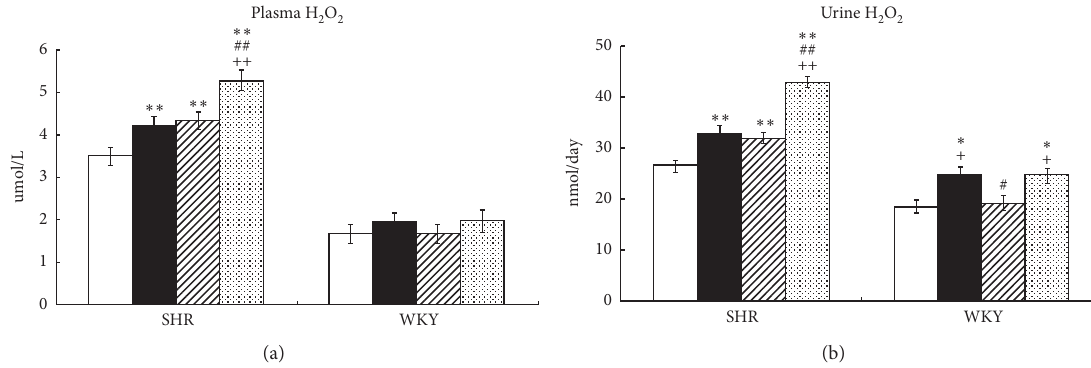
Figure 1: Effects of Ex and tempol on plasma and urinary H 2 O 2 in SHR and WKY. The H 2 O 2 in plasma (a) and urine (b) of SHR and WKY was compared among the control group (open bars), Ex group (closed bars), Tmp group (hatched bars), and Ex +Tmp group (checked bars) ( n � 10 in each group). ∗ P < 0 . 05 vs. the control group. ∗∗ P < 0 . 01 vs. the control group. ## P < 0 . 01 vs. the Ex group. ++ P < 0 . 01 vs. the Tmp group.